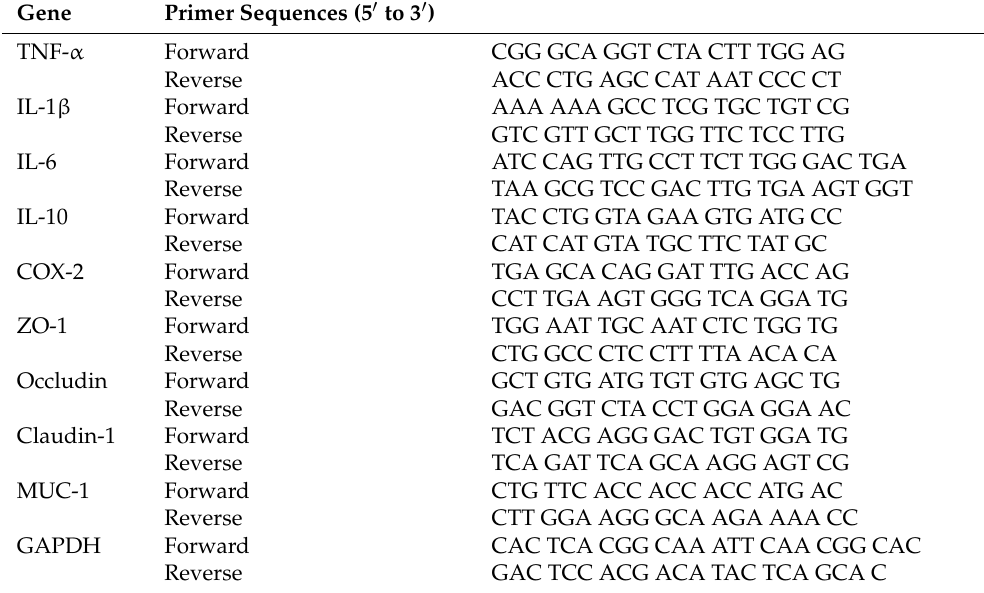
Table 1. Primer sequences used in this